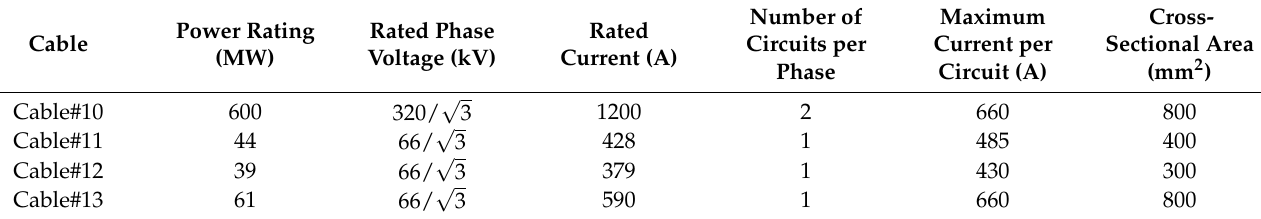
Table A5. AC-cables design for Architecture 3.